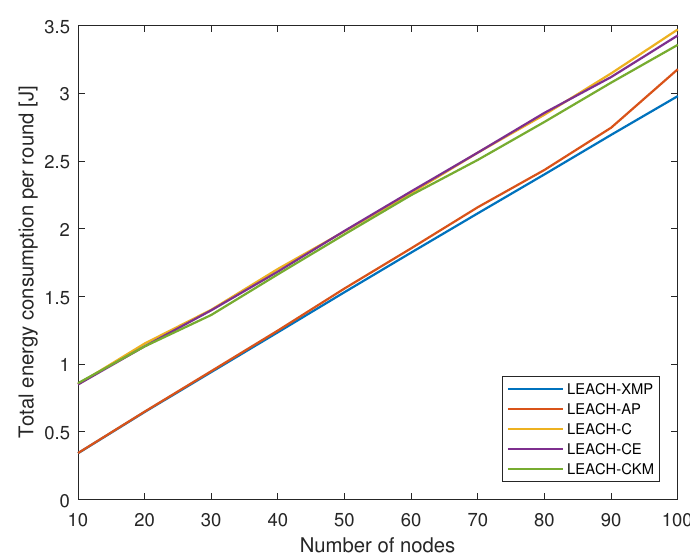
Figure 7. Total energy consumption per round versus number of sensor nodes.